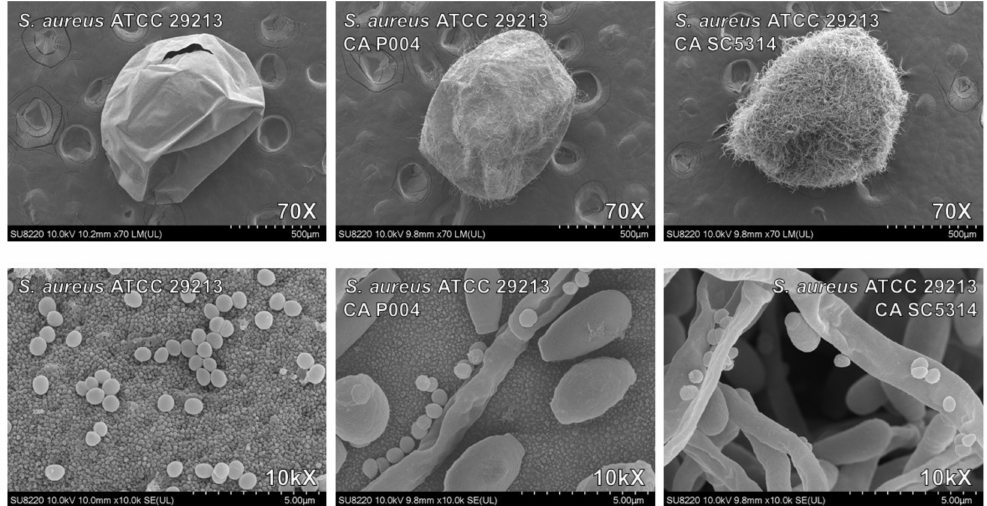
Figure 3. Scanning electron microscope graphs of biofilm morphology on fish embryo chorions. After 4-h adhesion and 24-h maturation, fish embryos that were infected with S. aureus ATCC 29213 only or that were co-infected with a low biofilm clinical strain P004 or wild-type SC5314 strains were used for SEM.